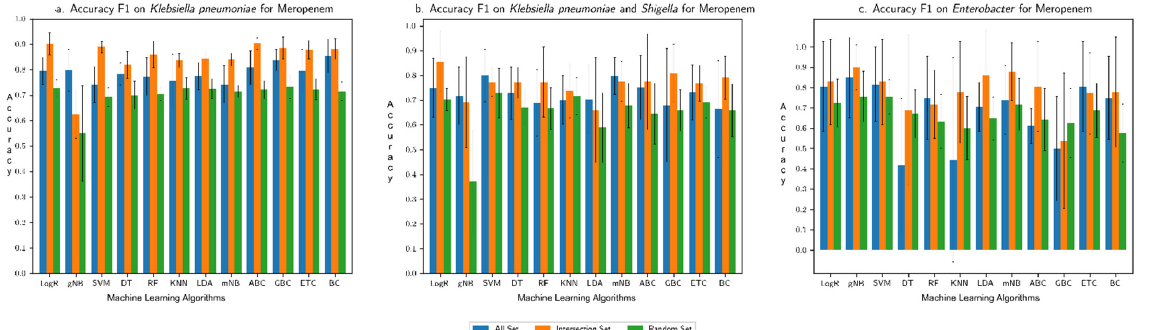
Figure 2. Overall accuracy (F1 score) produced by different machine learning algorithms in predict- ing resistance to ( a ) Doripenem for K. pneumoniae , ( b ) Doripenem for E. coli and Shigella , and ( c ) Imipenem for P. aeruginosa . “All Set” denotes all genes of a genome of interest, “Intersection Set” contains genes that consistently ranked high in their importance in discriminating resistant from susceptible strains in each round of cross-validation, and “Random Set” contains randomly sampled genes from All Set (same number of genes as in Intersection Set). Performance was assessed for each of three input datasets in a 6-fold cross-validation setting.